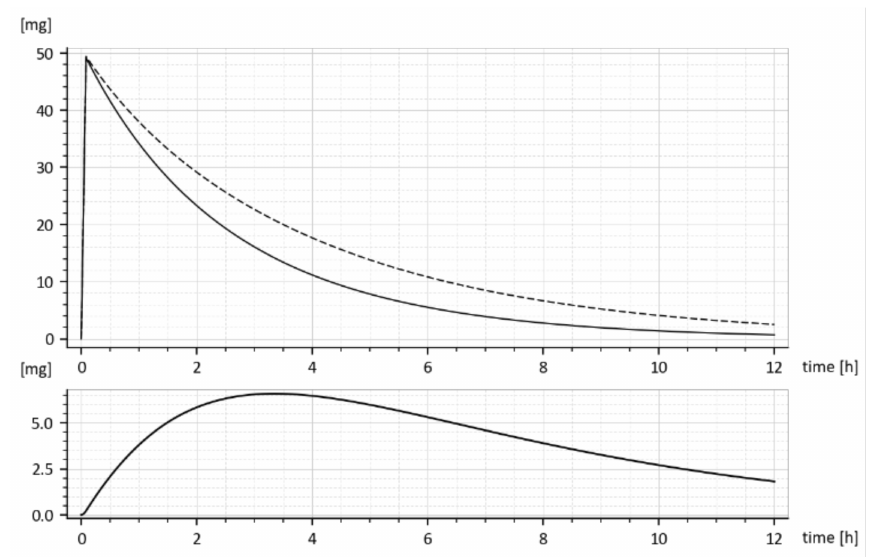
Figure 8. Predicted drug amounts x 1 (t) in the GIT without (dashed curve) and with the tenside (full curve). Below is the difference ( x 1without – x 1with ).